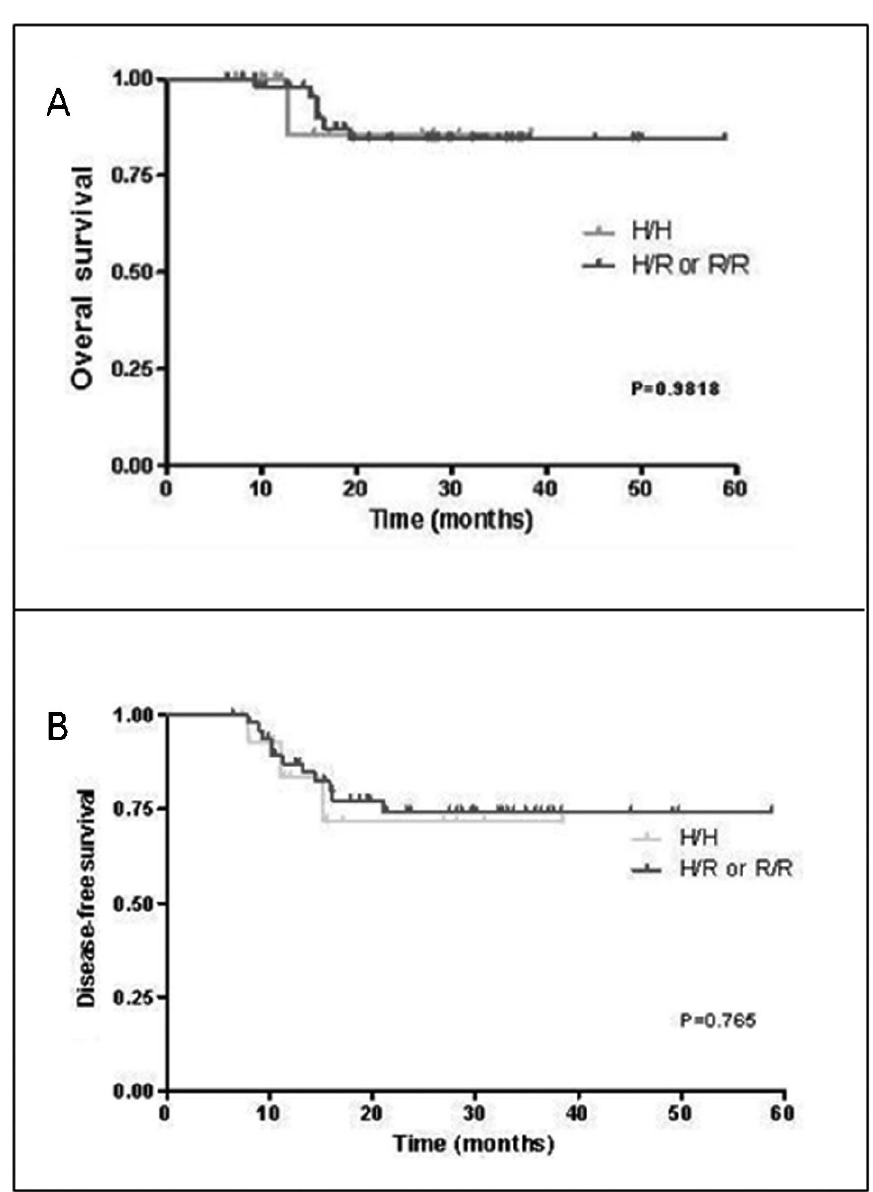
Figure 1- Effects of the H/R Fc c RIIA-131 polymorphism on 59 DLBCL patients treated with CHOP and rituximab. A. Overall survival, calculated from the beginning of chemotherapy to either the date of death or the date of the last follow-up. B. Disease-free survival, calculated from the beginning of the observed complete or partial treatment response until either the date of first recurrent disease event (relapse, disease progression, treatment failure) or the date of the